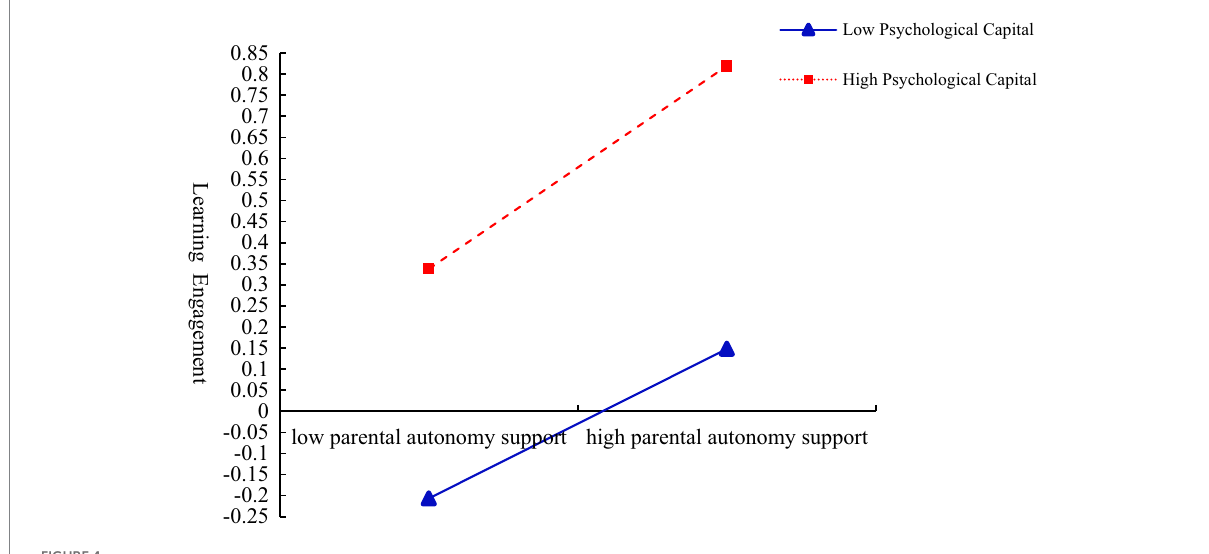
FIGURE 4 Moderation of psychological capital on the relationship between parental autonomy support and learning engagement.